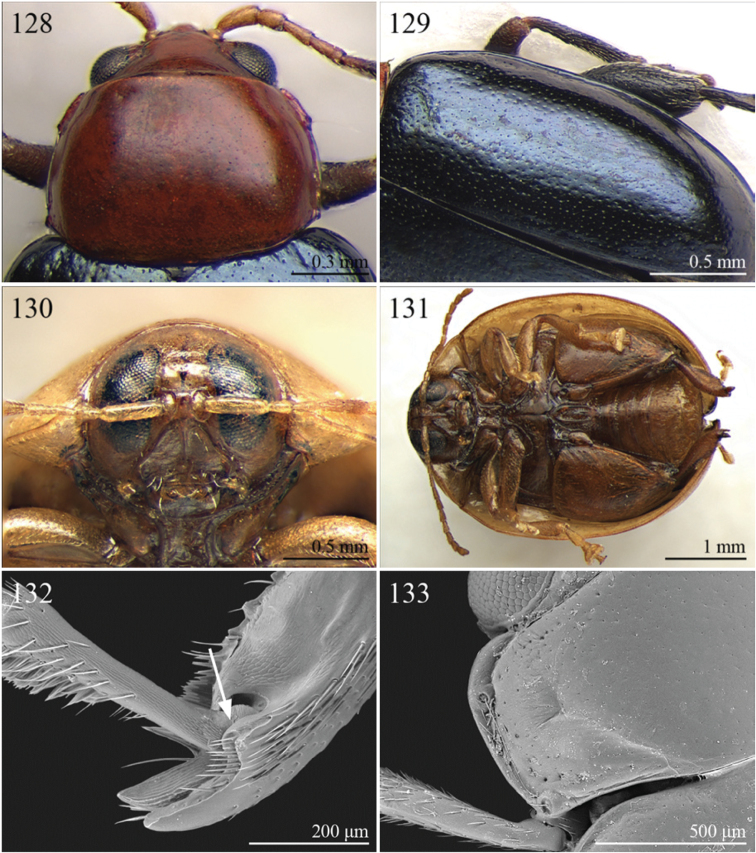
Morphological characters. 128
Aphthona braunsi (Jacoby), head and pronotum in dorsal view 129 Ditto, elytra in dorsal view 130
Argopistes silvestrii Weise, head in frontal view 131 Ditto, ventral parts 132
Argopistes sexvittatus Bryant, apical part of hind tibia 133
Argopistoides africanus (Bryant), sublateral sulci on pronotum.